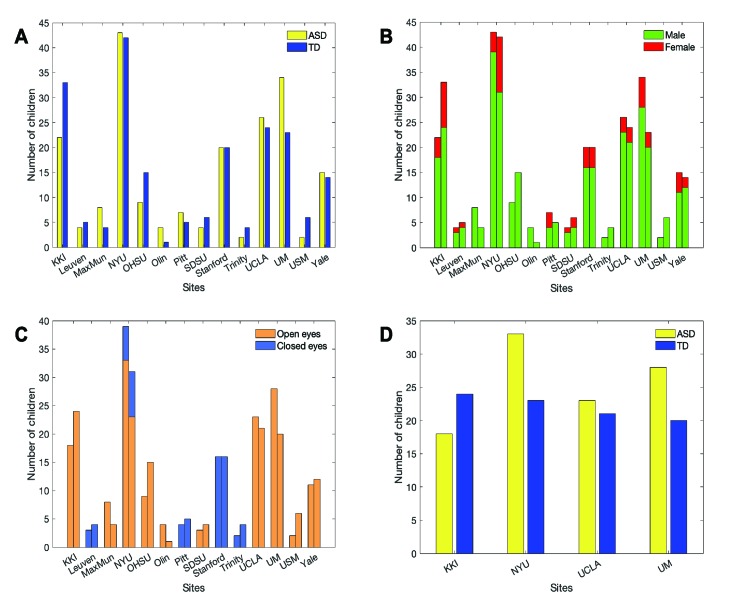
Number of children per ASD and TD groups (yellow = ASD, blue = TD) before (A) and after adopting selection criteria regarding sex (B), eye status during scan (C) and sample size at each site (D).